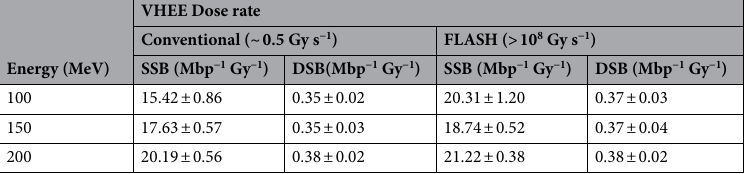
Table 3. Single- and double-strand break yields following aqueous plasmid irradiation with 100–200 MeV electrons at Conventional and FLASH dose rates, calculated using the McMahon 32 fit. Standard error based on six agarose gel electrophoresis repeats for 200 MeV and five for 150 and 100